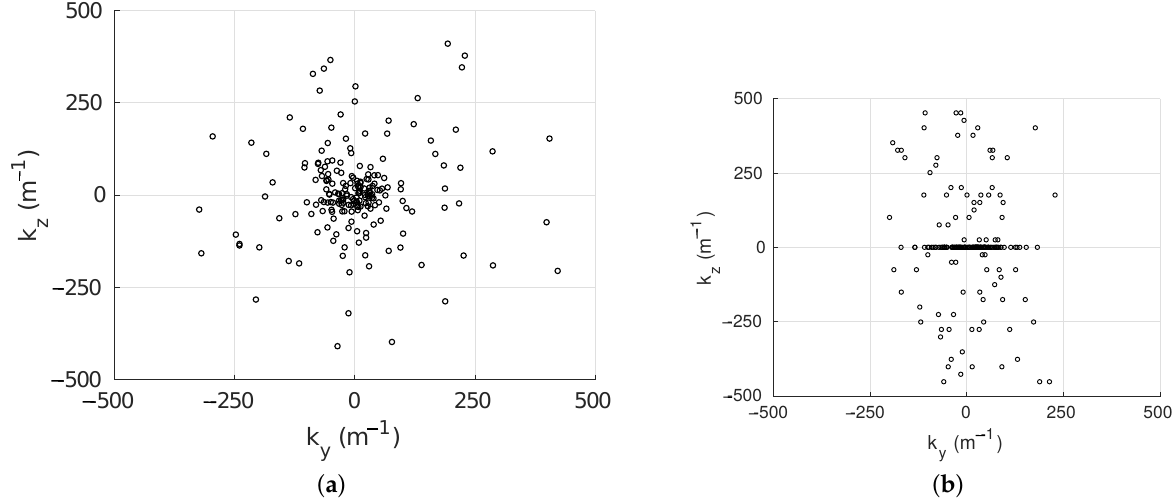
Figure 3. Wavenumber distribution for ( a ) RFM method and ( b ) RFM-P extension, both for 200 modes and for L z = 0.25 m with k Max x = k Max y = k Max z = 466 m − 1 (mesh size chosen as 2.93 × 10 − 3 m). For the RFM-P approach, N Eff = 198 modes, = 114 and N = with N k k z (cid:54) = 0 z = 0